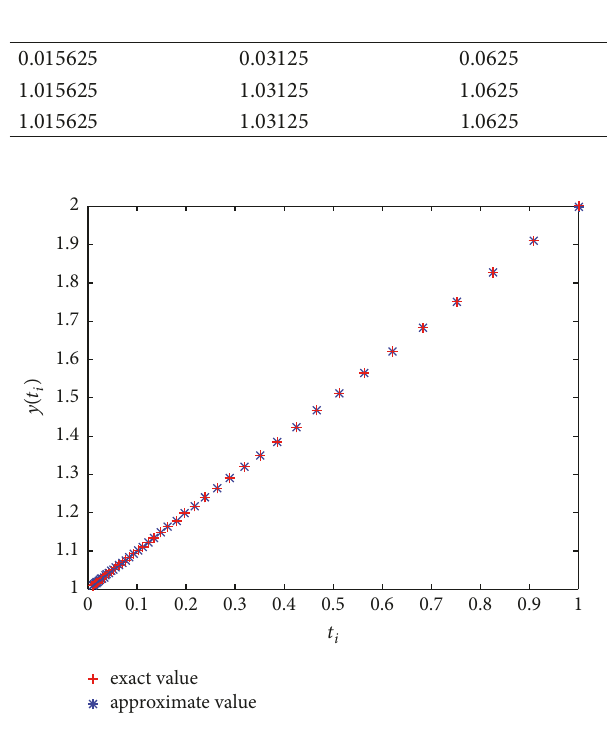
Figure 2: For 𝑞 = 1.1, 𝑁 0 = 50